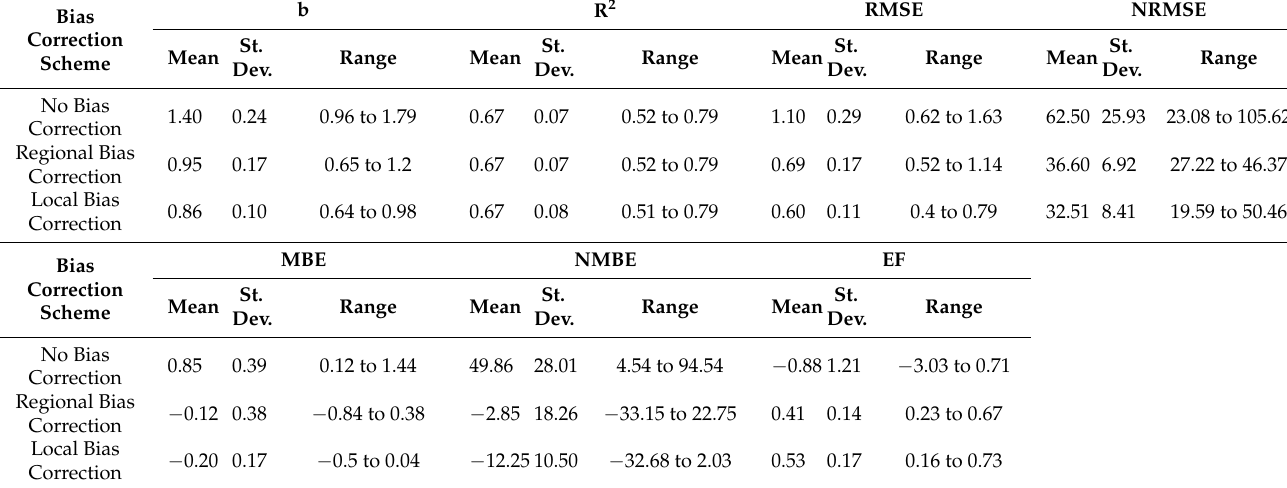
(Table 3), the maximum value of R 2 (0.79) was recorded for Beja while the minimum values of R 2 (0.52) was obtained for Elvas (Table S5), showing a moderate to high fit between speed data (Table 8) show a mean coefficient of regression of 1.40, with an average RMSE of 1.10 m s − 1 , a mean NRMSE equal to 62.50% and an average modelling efficiency of − 0.88. varies from 0.12 to 1.44 m s –1 . Bias correction increases the accuracy of NASA POWER wind speed estimation significantly. The mean EF increased to 0.40 (an improvement of 146.3%), for a regional correction, and to 0.53 (an increase of 160.7%), when locally correcting the bias. The RMSE decreased 37.4% (to 0.69 m s − 1 ), for the former, and 45.7% (to 0.60 m s − 1* , for the latter. The most frequent (Supplementary Figure S5) NMBE and EF for the raw NASA POWER wind speed data is higher than 60% (42% of all locations) a lower than 0 (71% of all locations), respectively; however, if the dataset is locally bias corrected, the most frequent NMBE ranging − 10.0 to 10.0%, with more than 60% of the stations showing an EF higher than 0.50. Table 8. Mean and range values of the accuracy metrics relative to NASA POWER wind speed with and without bias correction for the full data set of all 14